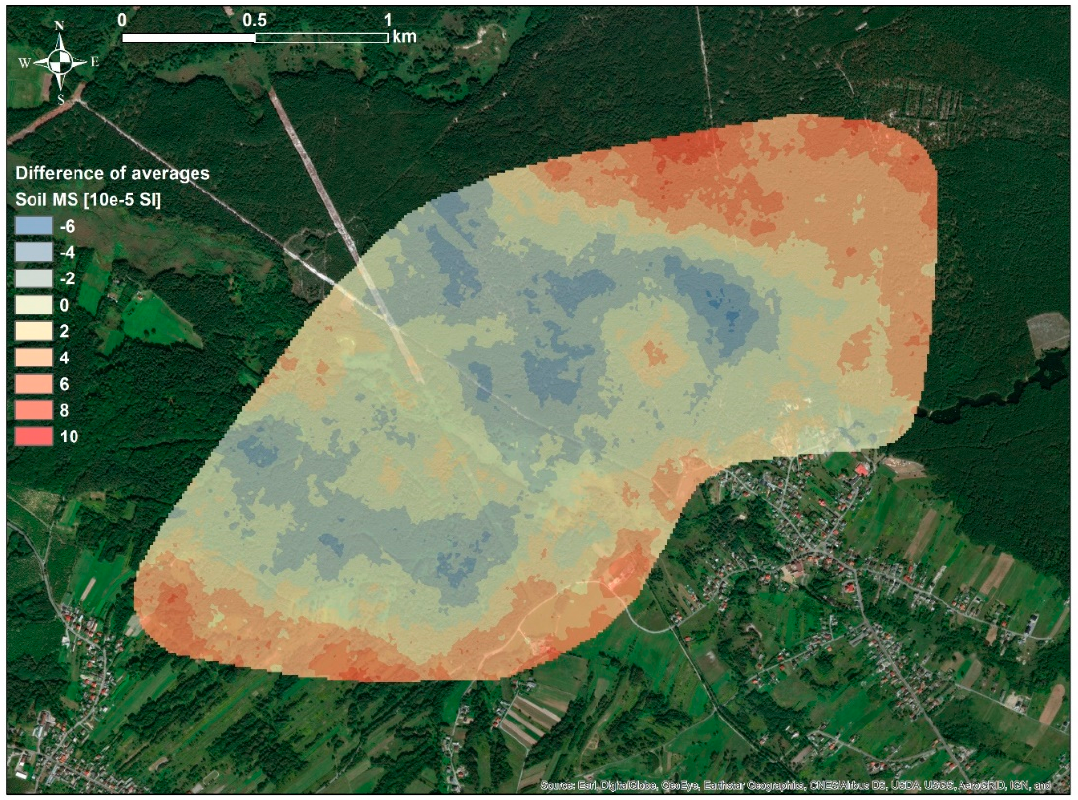
Figure 3. Spatial distribution of differences between κ sim-avg simulated using κ non-avg and κ sim-avg simulated using κ avg .